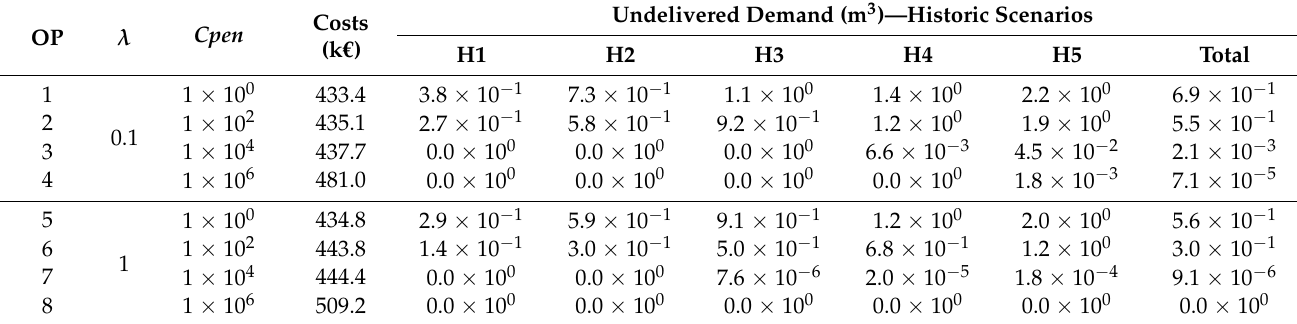
Figure 4. Pipe diameters for the optimized deterministic design of the WDN. The different colors indicate the pipe diameter for each pipe (links in mm) and the pressure at the nodes (nodes in m) for the deterministic water demand in the hydraulic model (PF = 2.77). The minimum pressure requirement of 20 m is met at all nodes in the network. Diameters are significantly decreased when compared to the diameters of the currently installed network (Figure 2). Table 6. Summary of the results obtained for the different optimization problems